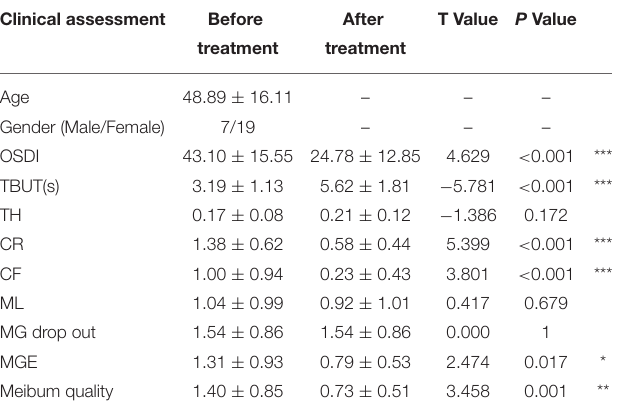
TABLE 1 | Clinical parameters before and after treatment of IPL in MGD ( n = 26).